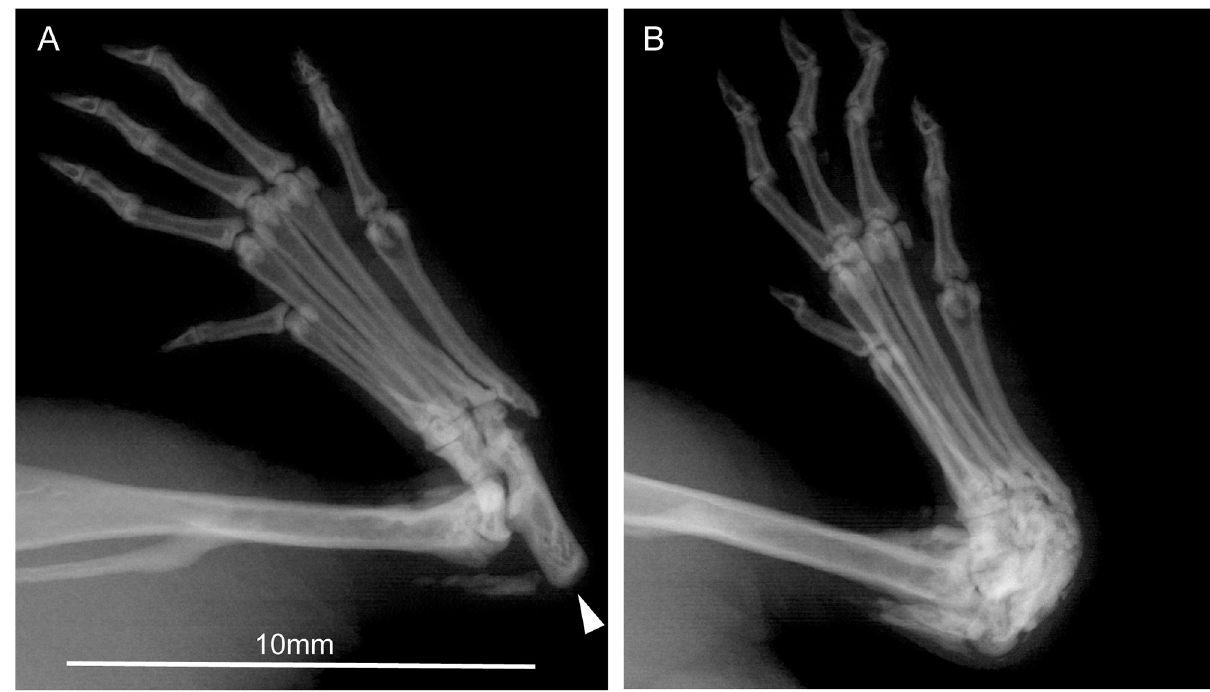
Fig 2. (a) X-ray image of the normal position of the calcaneus (arrow) within the tarsal joint and (b) with caudo-dorsal dislocation of the calcaneus.